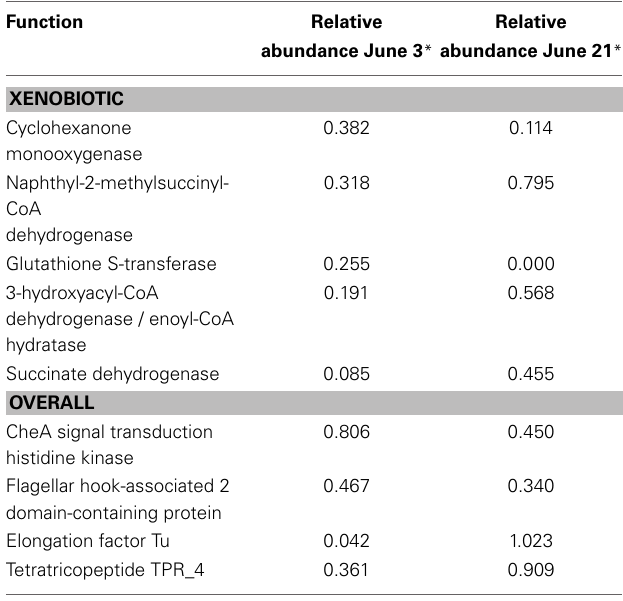
Table 1 | Top xenobiotic and overall metatranscriptomic functions mapping to Marinobacter aquaeolei